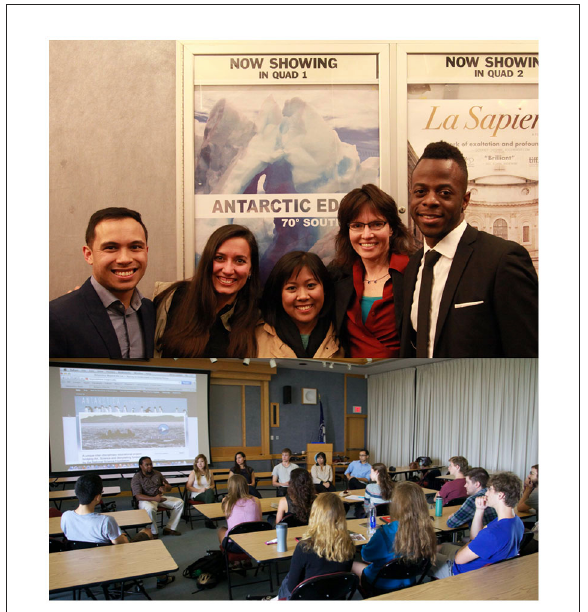
FIGURE7 Undergraduate students from a variety of majors present Antarctic Edge: 70 ◦ South to the public at the documentary’s theatrical release in New York and at Woods Hole Oceanographic